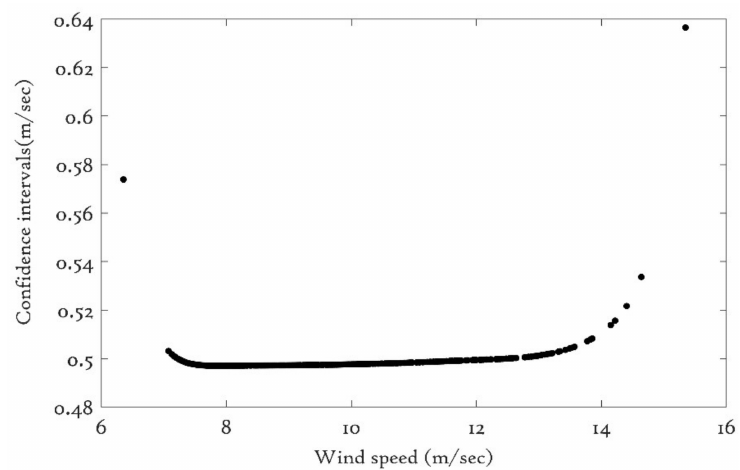
Figure 15. GP rotor speed curve uncertainty.